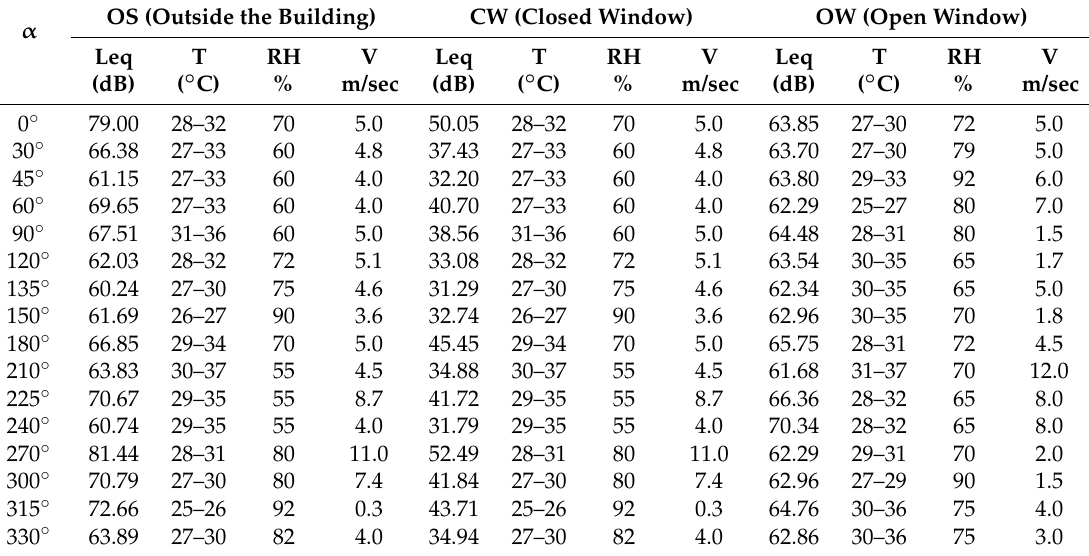
Table 4. Summary of average sound pressure level during aircraft take-off.